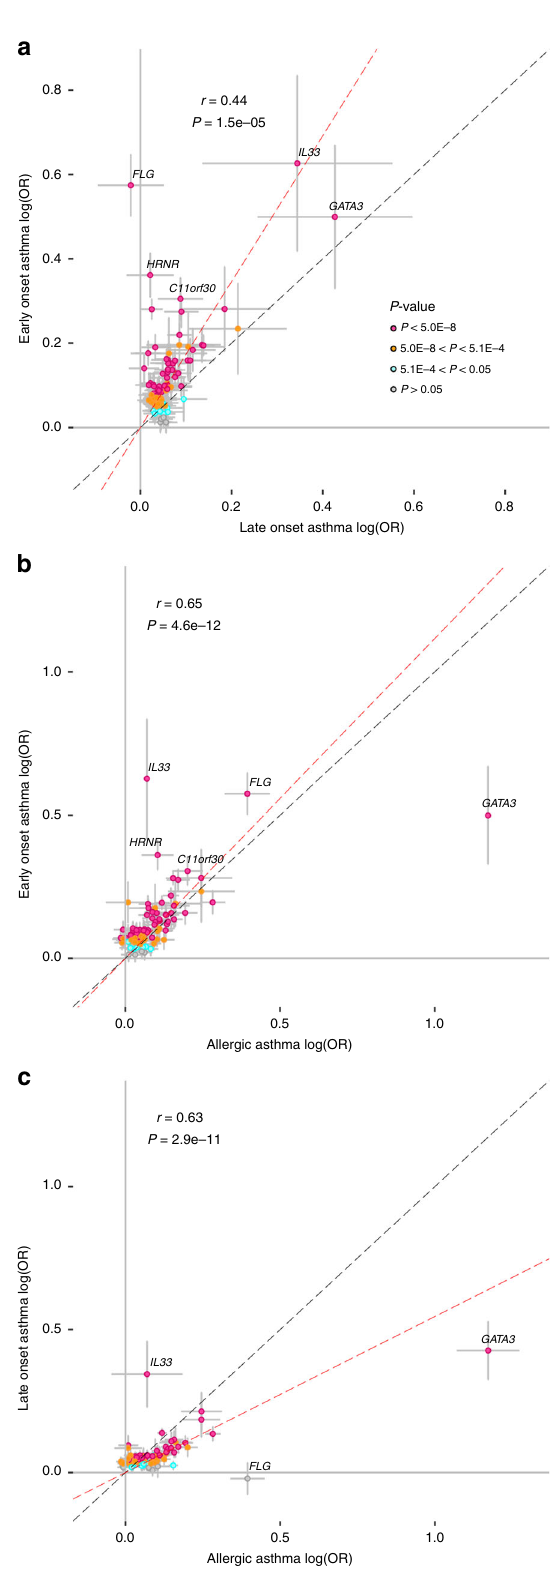
asthma pathogenesis 50,51 . We show evidence that two low frequency variants in TNFRSF8 and TGFBR1 associate with decreased asthma risk through loss of function and gain of function, respectively. Other susceptibility loci point to genes involved in in fl ammation and airway remodeling.